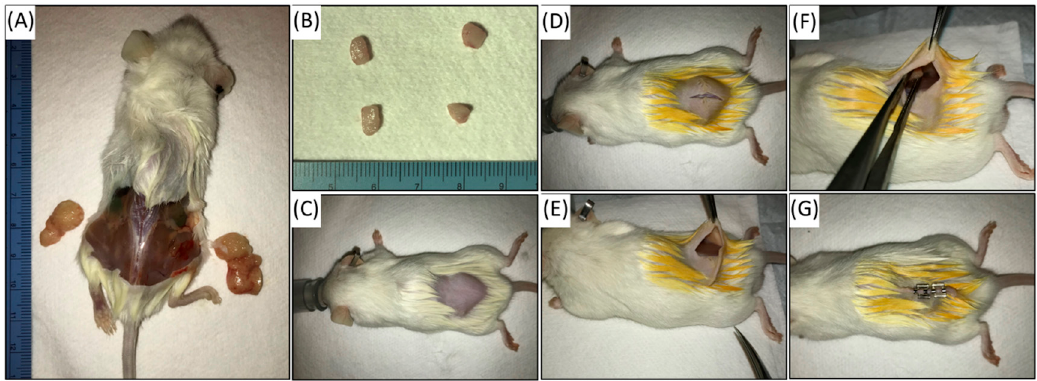
Figure 1. Passaging of patient-derived xenograft (PDX): NSG mice are euthanized once tumors reach approximately 1.5cm as measured by Vernier caliper ( A ). Tumors are explanted and divided into 5mm pieces for engraftment ( B ). Additional tumor specimen is collected at every passage for formalin fixation and paraffin embedding to confirm faithful maintenance of malignant histology. The new host NSG mouse at 6-8 weeks is anesthetized and prepped for grafting ( C ). The hind region is shaved and cleaned with alcohol and betadine. A 1cm midline incision allows for bilateral implantation, if desired ( D , E ). Tumor specimen is placed in subcutaneous pouch overlying the muscle ( F ). Matrigel can be used to keep tumor in position. Skin is closed, and mouse is started on amoxicillin for infection prophylaxis ( G ).